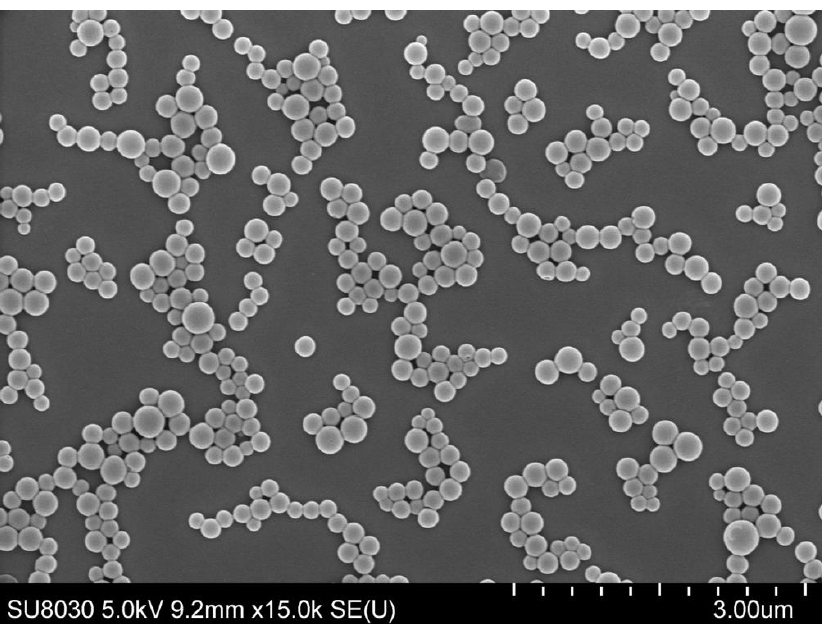
Figure 1. Size distribution of GAR-PLGA-ES100 NPs by DLS measurement.